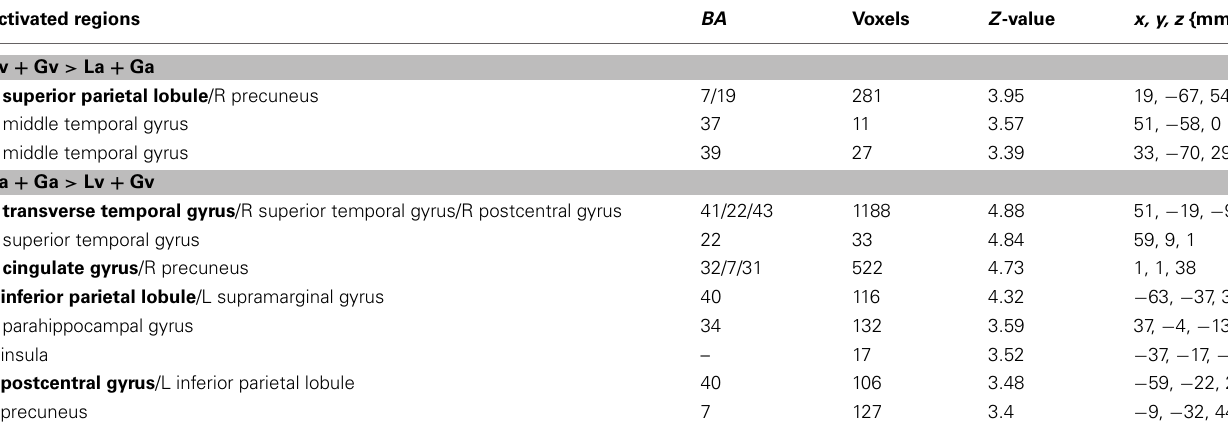
Table 2 | Brain regions showing significant differences in activation between visual and auditory tasks. Activated regions